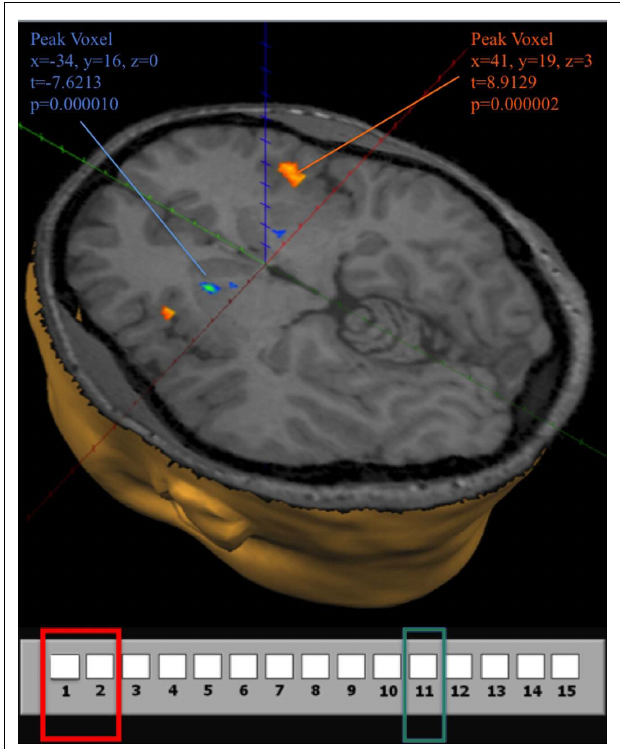
FIGURE 8 | Brainactivity at the losing position 11 in G (15, 3). Contrast obtained from a GLM with 16 predictors on all 12 subjects. In the GLM we use the same 7 groupings for positions in the game, and differentiate between positions during the first (early) and last (late) 10 trials, for a total of 14 predictors. An additional predictor for computer choices and a constant term describe the full model.The contrast used in the figure shows activation when the current position is 11 during both early and late trials compared to activation at positions {1, 2} during early and late trials. The map shows activation at a false discovery rate q < 0.05.